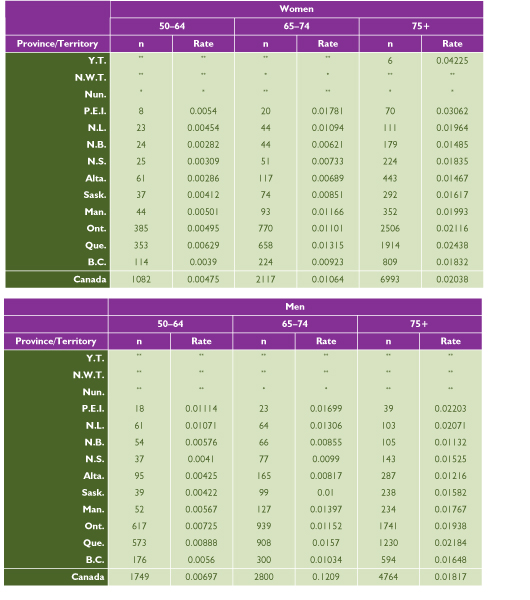
Age and Sex-Specific Stroke Admission Rates in Canada by Province and Territory, 2000–2001. Source: Canadian Institute for Health Information, Hospital Morbidity Database